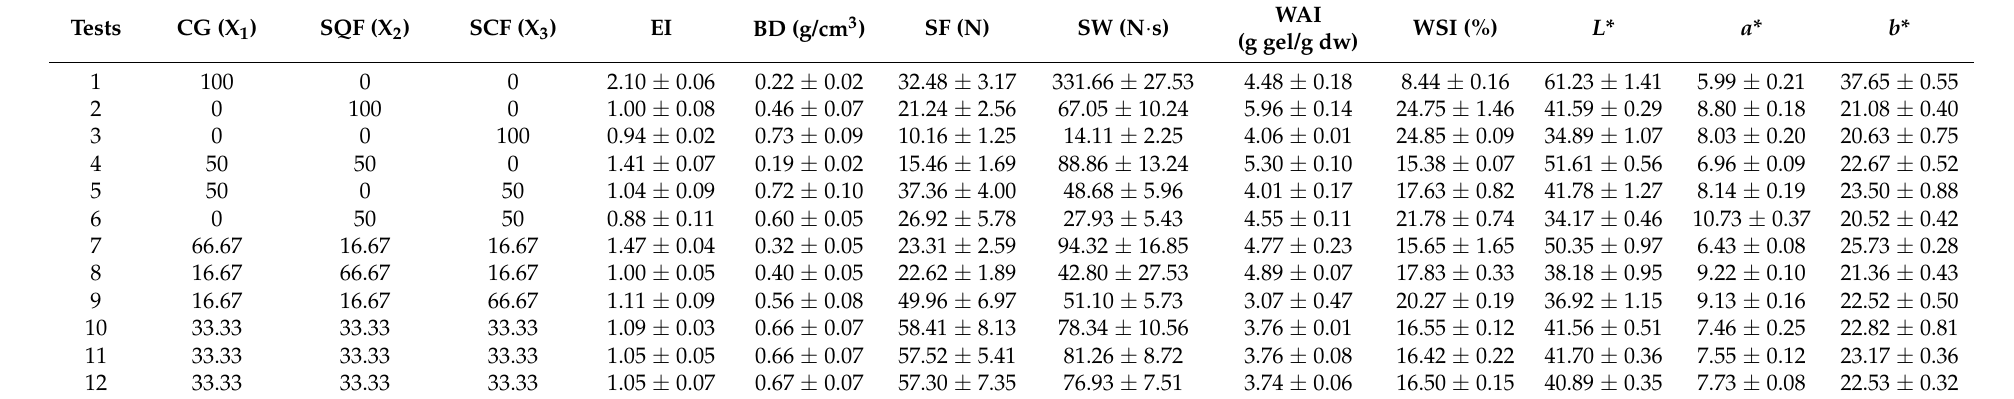
Table 4. Physical properties of extrudates made with CG, SQF and SCF used in single, binary and ternary